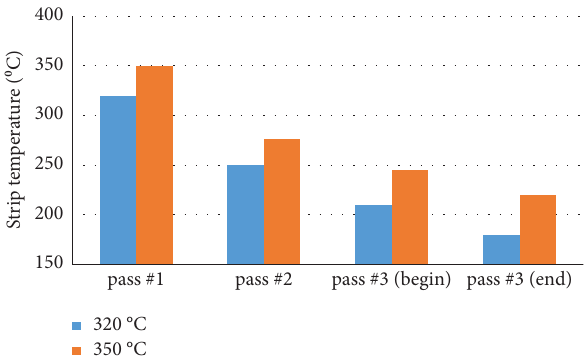
Figure 4: Te change in the billet temperature at the frst stage of rolling after TE. Te temperature of the billets before rolling was 320 ° C or 350 ° C. Rolling occurs in 3 passes from one heating.